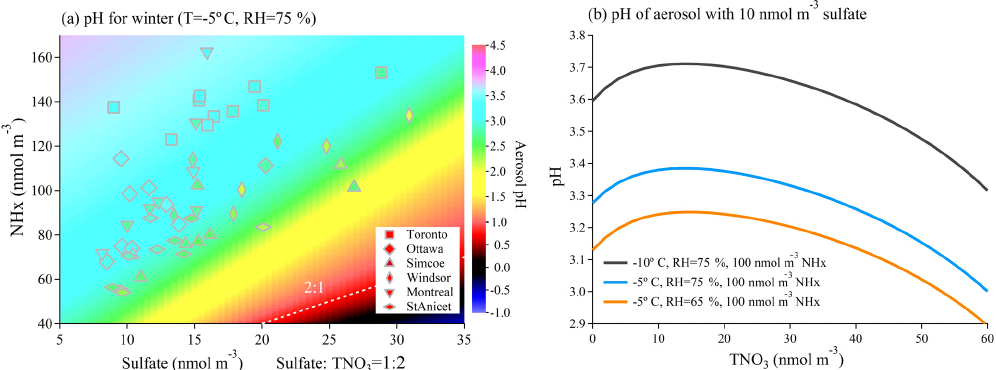
Figure 8. (a) The plot of aerosol pH under wintertime meteorological conditions ( − 5 ◦ C, RH = 75%) under different combinations of sulfate and NH x with more focused region compared to Fig. 5d. The markers on the graph represents the average wintertime (data from January and February) sulfate and NH x concentrations in each year in each sampling site with colour indicating average pH value. (b) pH of aerosol with 10nmolm − 3 sulfate under different combinations of temperature and relative humidity as the function of TNO 3 in the